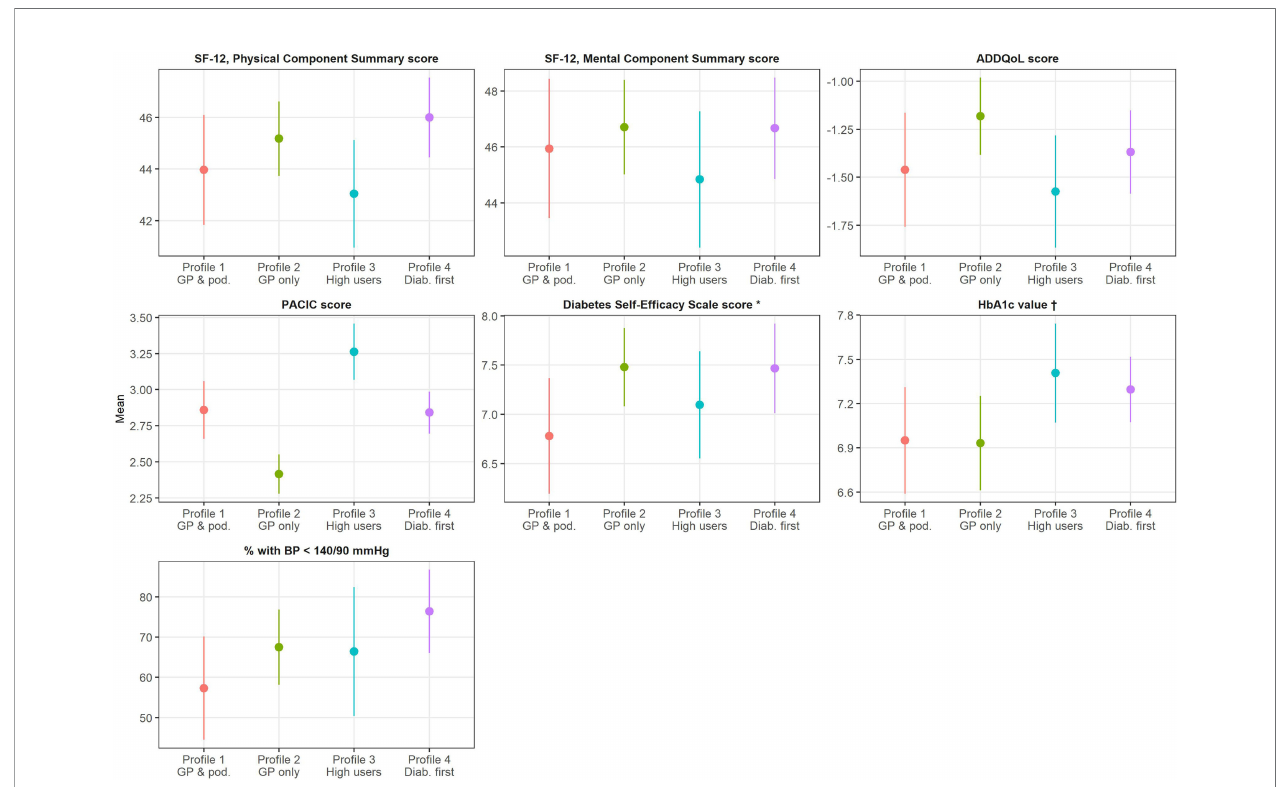
FIGURE 3 | Adjusted outcomes of care, by healthcare use pro fi le. GP, general practitioner; SF-12, 12-Item Short-Form Health Survey; ADDQoL, Audit of Diabetes- Dependent Quality of Life; PACIC, Patient Assessment of Chronic Illness Care; HbA1c, glycated hemoglobin; BP, blood pressure. Means (or probabilities) estimated from linear (or logistic) regression models (predictive margins). Adjustment: age, sex, living arrangement status, residential location, education level, mandatory health insurance model, subsidies for mandatory health insurance, and diabetes-related complications. *Only participants of the 2017 recruitment phase. † Only participants who have already heard about